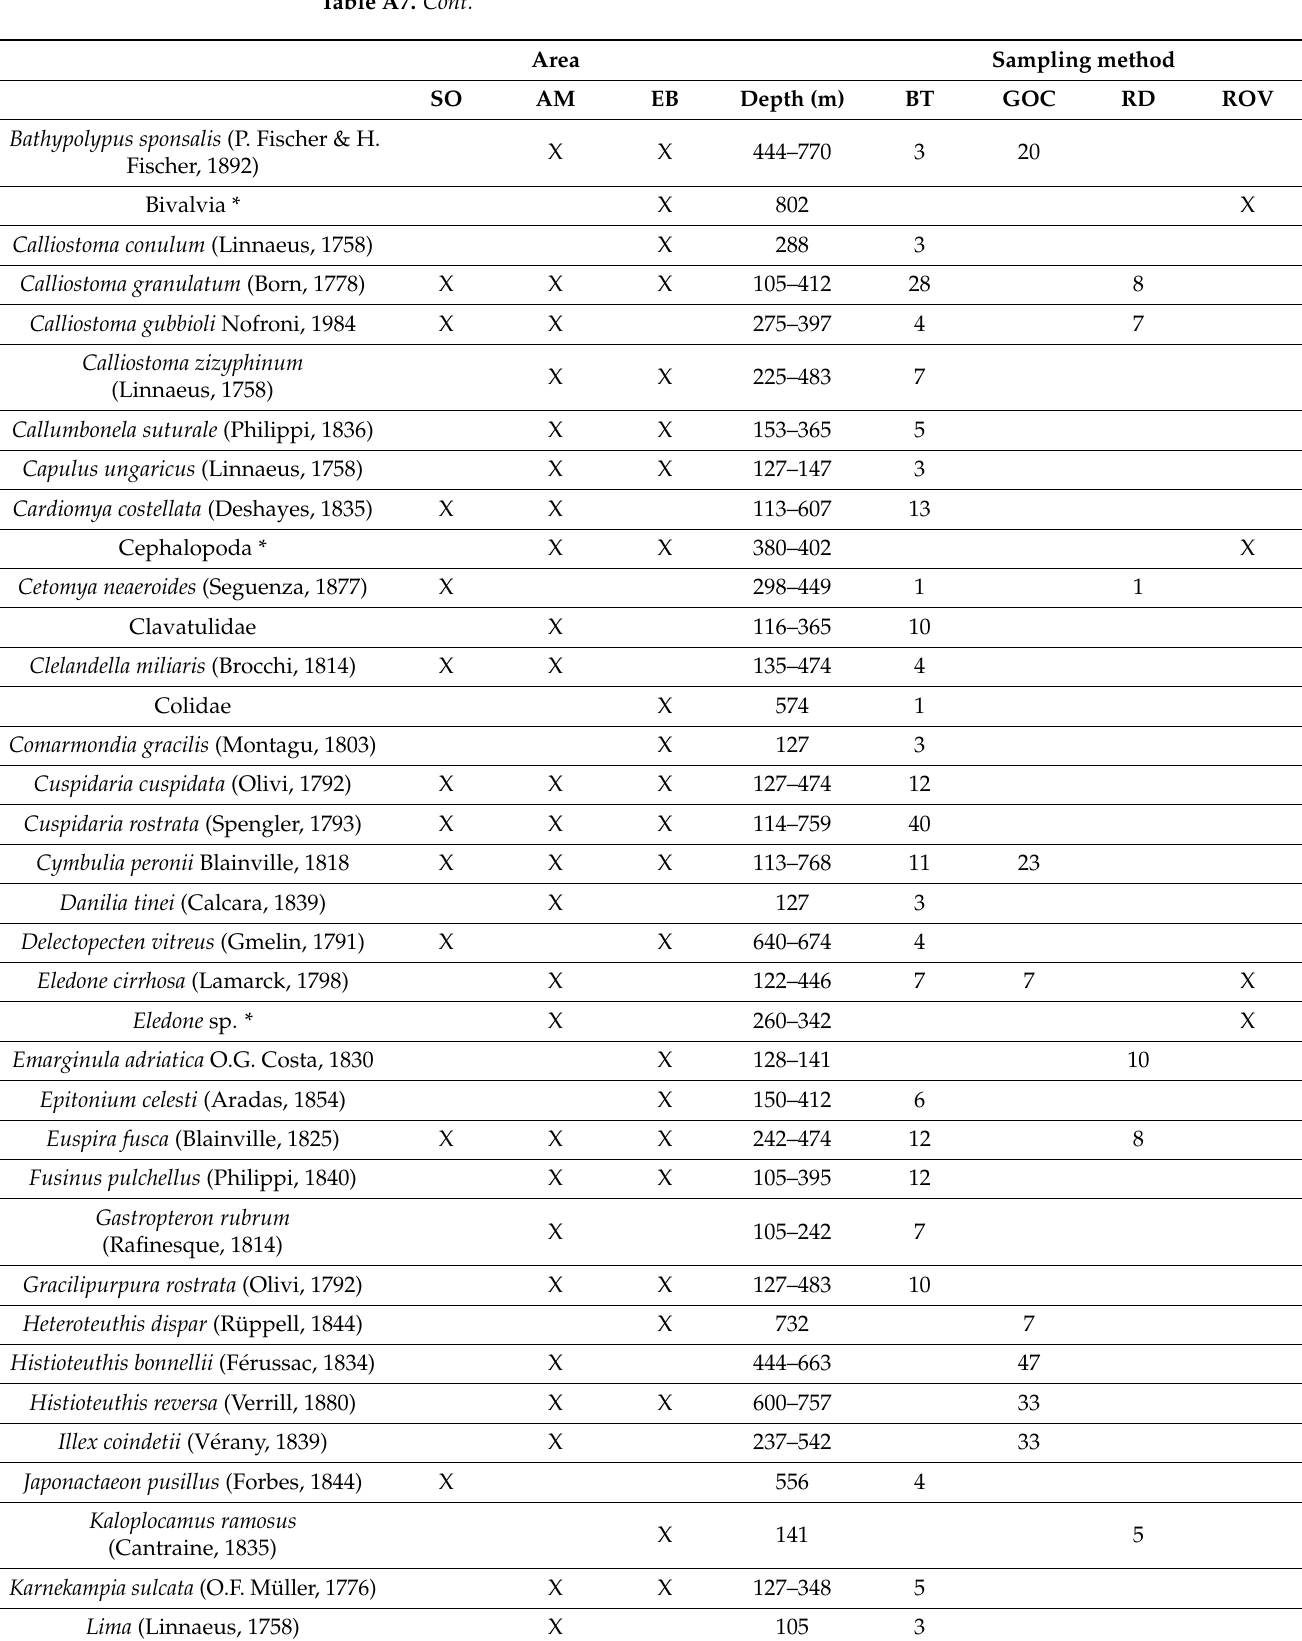
Table A7. Cont. Area Sampling